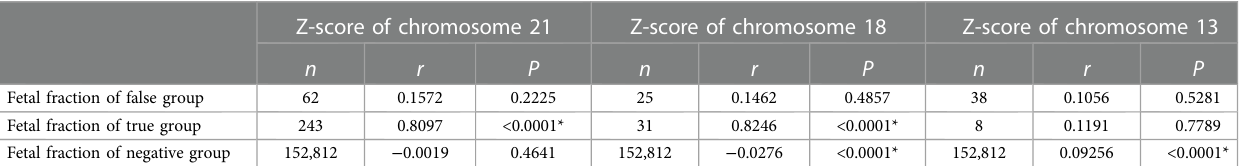
TABLE 2 Relationship between the z-scores of chromosomes and fetal